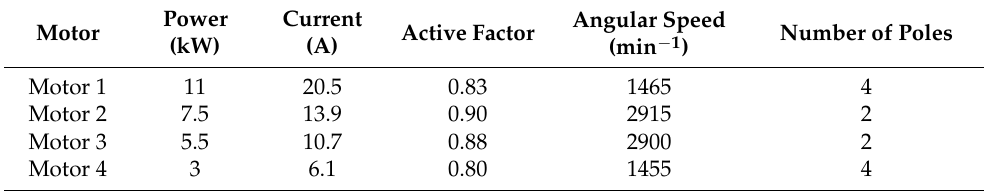
Table 2. The rated values of three-phase induction motors used to validate the proposed system.